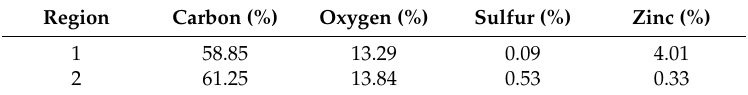
Table 1. Elemental compositions analyzed by WDS in Regions 1 and 2 in Figure 5. Region